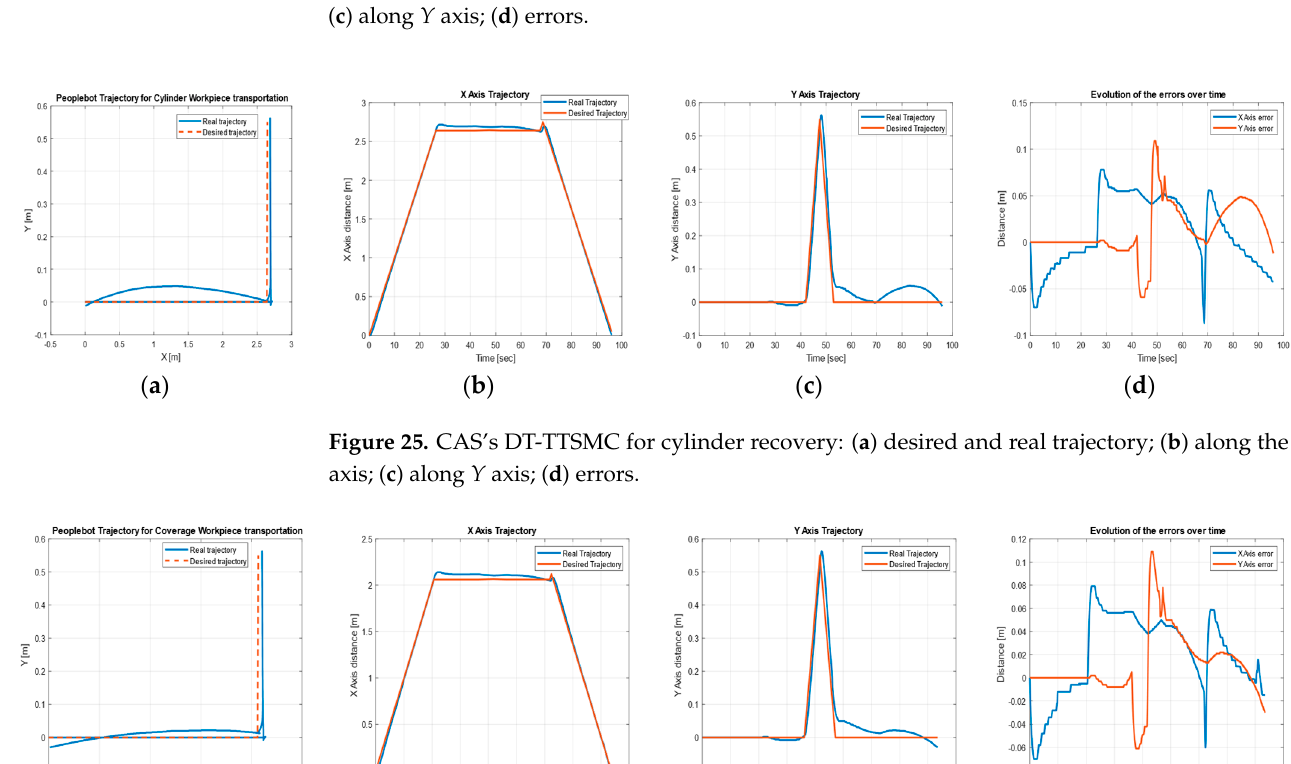
Figure 26. CAS’s DT-TTSMC for body recovery: ( a ) desired and real trajectory; ( b ) along the X axis; ( c ) along Y axis; ( d ) errors.